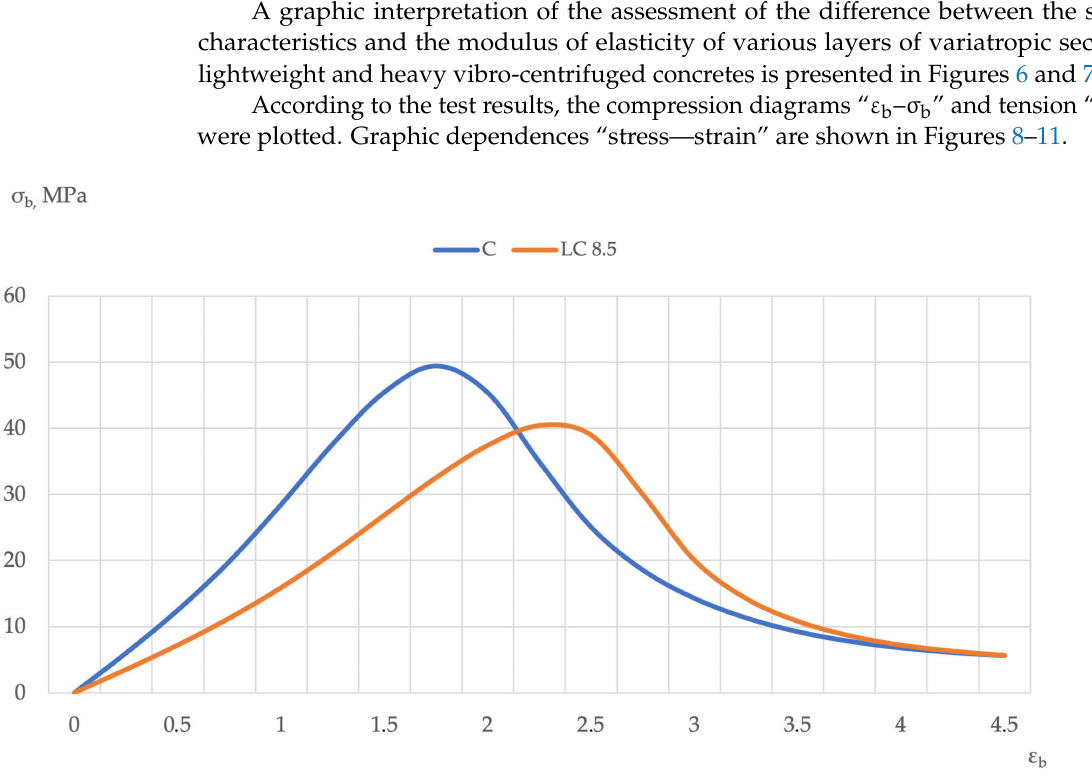
Figure 8. Diagram “stress—strain” in compression for the integral characteristics of vibro-centrifuged concrete (C—control composition: heavy concrete on non-activated water, LC 8.5—lightweight concrete on activated water with pH = 8.5).